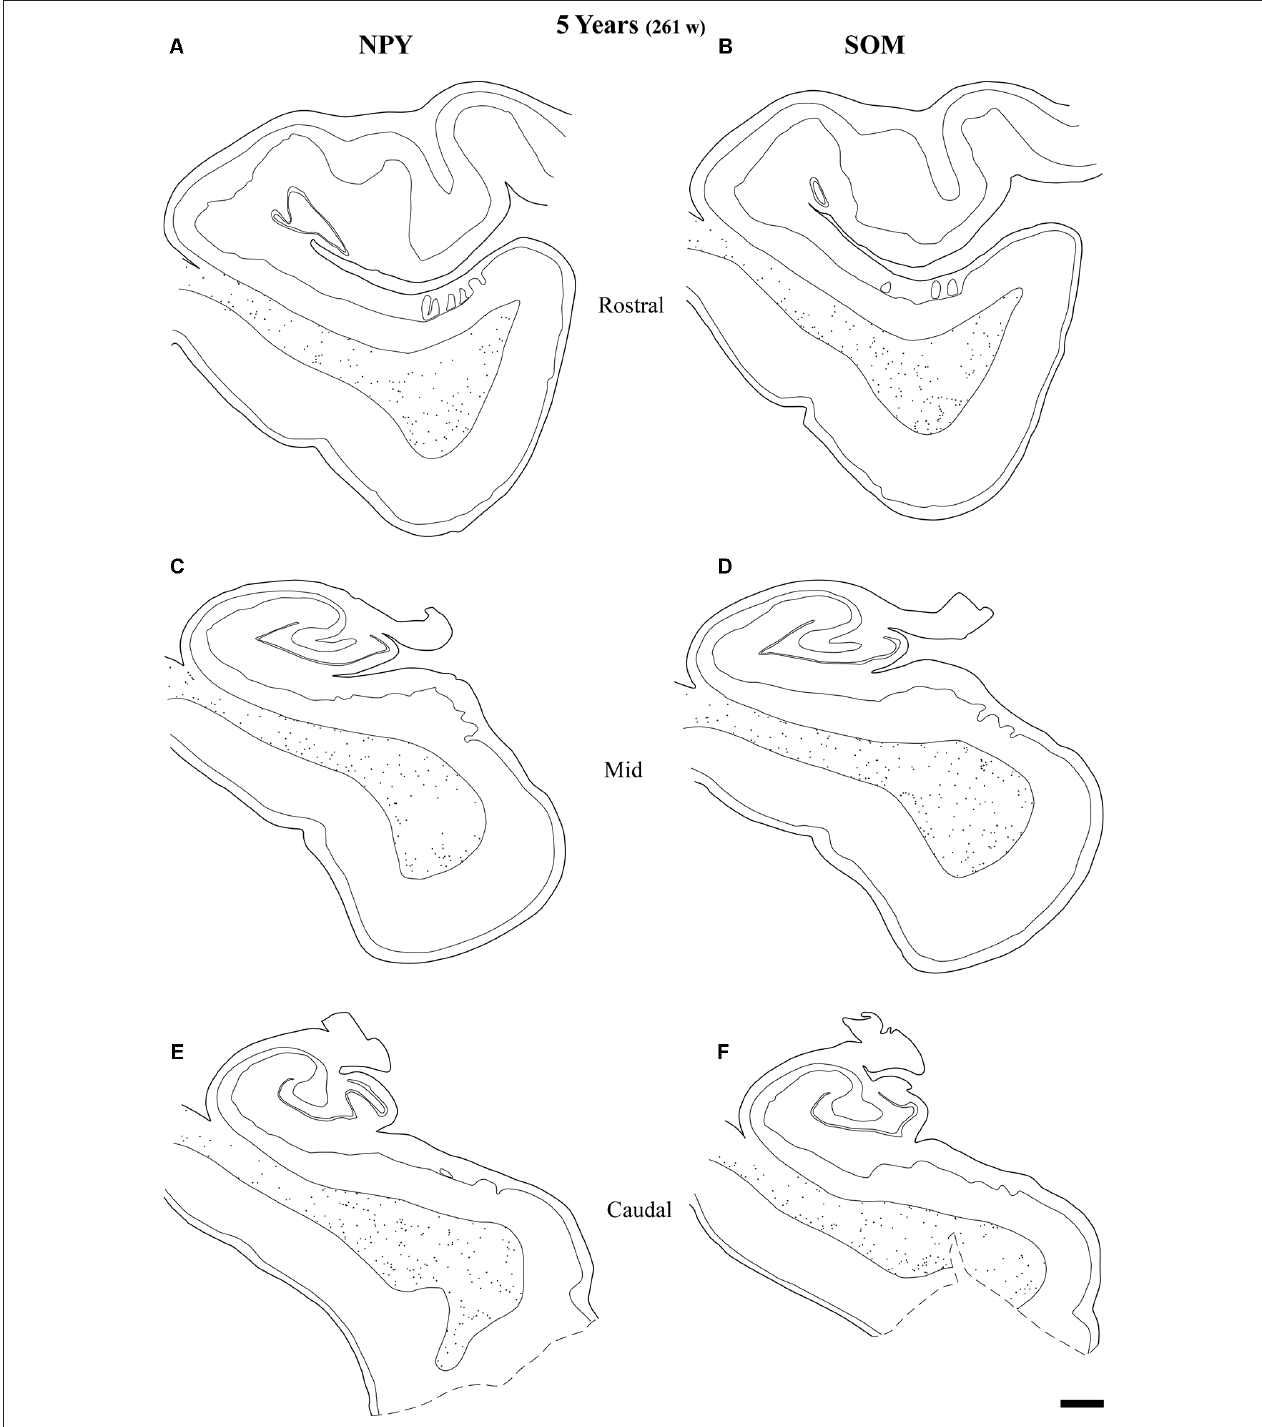
FIGURE 11 | Line drawings with the distribution of NPY- and SOM-28-immunoreactive neurons in the angular bundle of a 5 years old case at rostral (A,B) , mid (C,D) and caudal (E,F) levels. Note the decrease in density at all levels compared to younger ages. Other conventions as in Figure 3 . Scale bar is 2 mm.